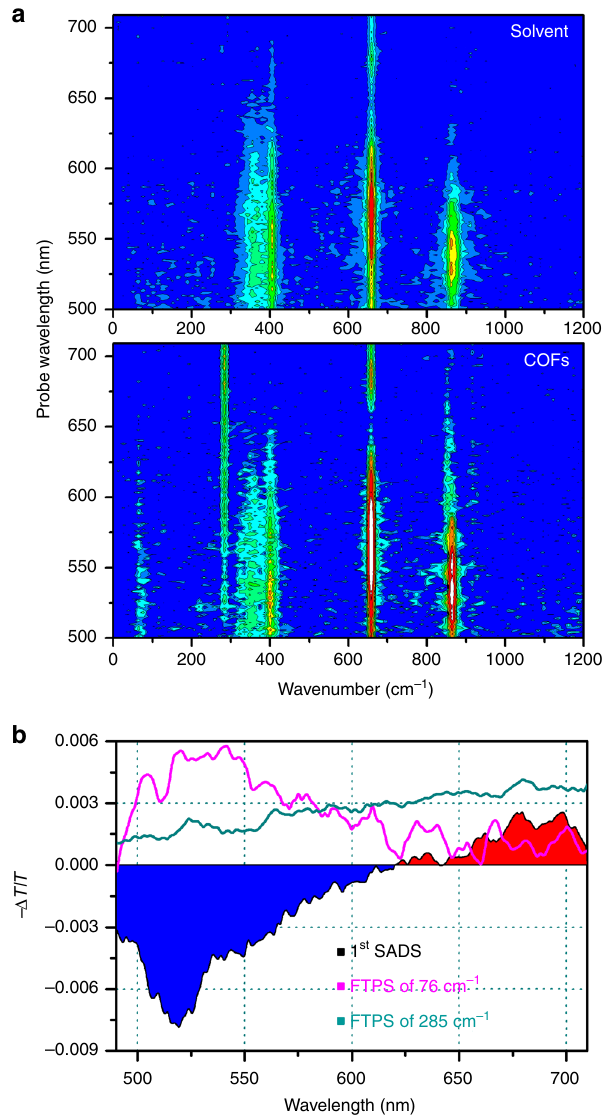
Fig. 3 Wavelength-resolved Fourier transform power spectra. a Wavelength-resolved Fourier transform power spectra (FTPS) of neat DMF (top) and COFs dispersed in DMF (bottom) with the probe spectral window of 500 – 710 nm. The Fourier power spectra of COFs have peaks at 76 and 285 cm − 1 , which are absent in the FTPS of pure solvent. b Comparison of SADS (black) with the slices of wavelength-resolved FTPS at selected oscillation frequencies. In the SADS, the blue- and the red- shaded area indicate negative and positive amplitude of the TA signal, respectively. The amplitude of the 76 cm – 1 oscillation is dominant in the spectral range of ground-state bleaching and stimulated emission of the fi rst SADS, whereas the 285 cm – 1 mode is manifested in the entire